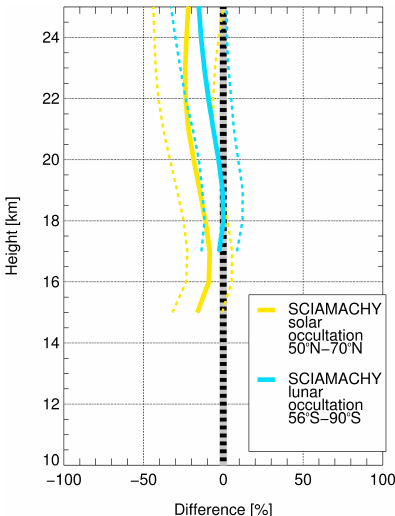
Figure 15. Comparison between occultation (lunar and solar) and limb (V3.01) water vapour profiles from SCIAMACHY. The SEM is not visible because it is smaller than the line